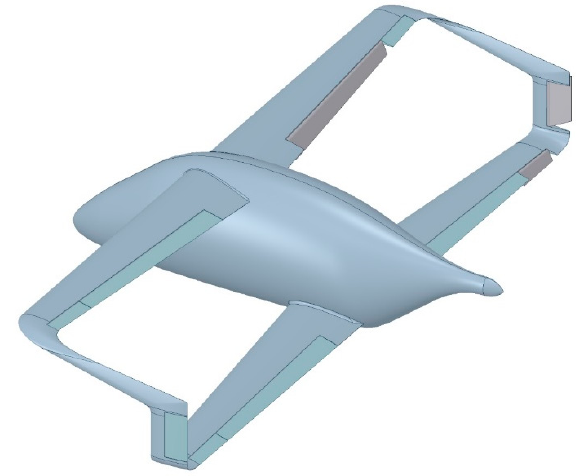
Figure 1. General view of the light boxplane model, geometry taken from [19].